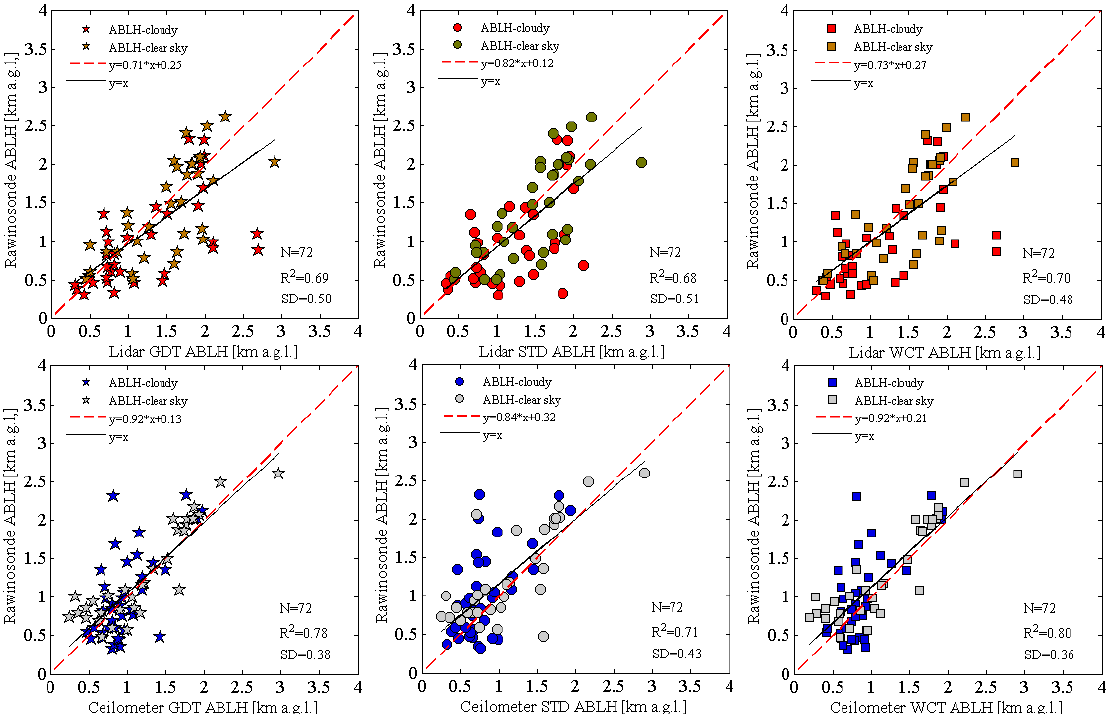
Figure 2. Correlation plots of the atmospheric boundary layer height (ABLH) derived from rawinsondes (bulk Richardson method) at 00:00 and 12:00 UTC in Legionowo versus those derived using the gradient method GDT (left, stars), standard deviation method STD (middle, circles), and wavelet covariance transform WCT (right, squares) algorithms applied to the PollyXT lidar (top) and the CHM15k ceilometer (bottom) in Warsaw. The period of July to October 2013 is covered. In brown/gray, the ABLHs derived in clear-sky conditions and in red/blue for boundary layer cloud conditions.